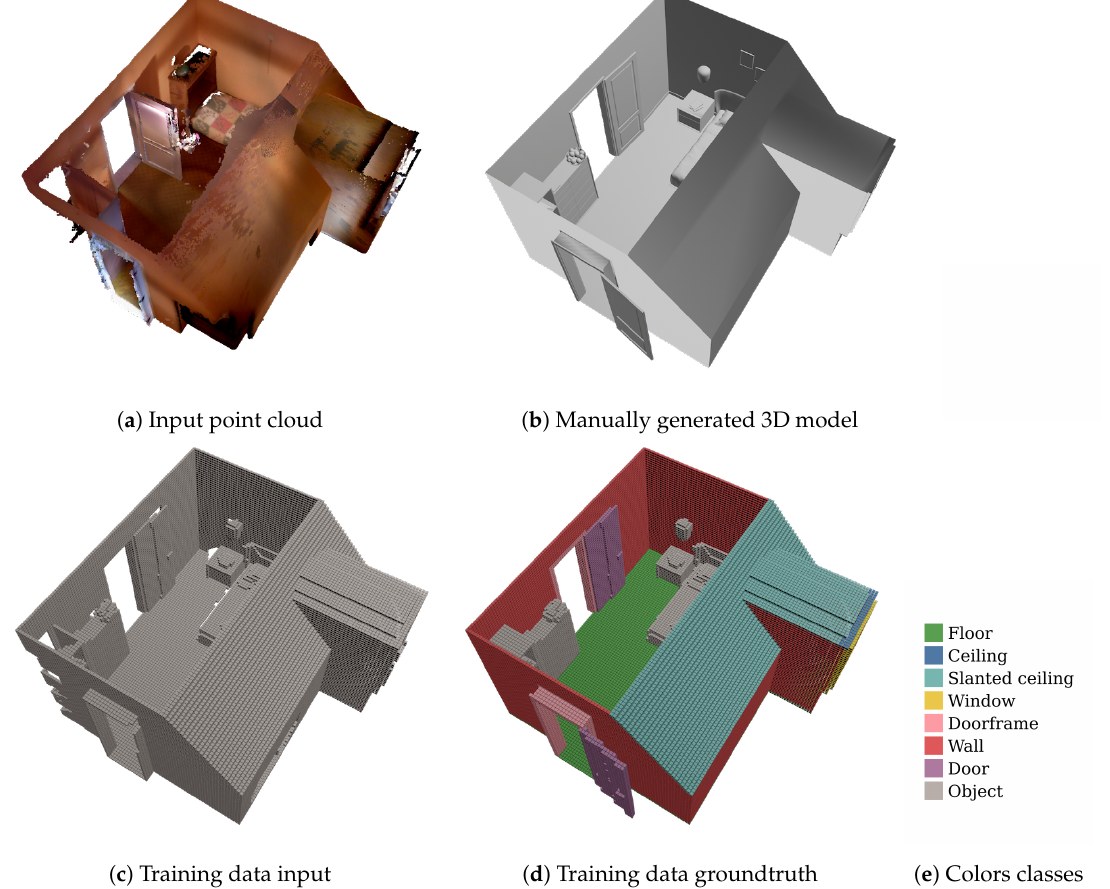
Figure 1. Overview of the extraction of our synthetic training